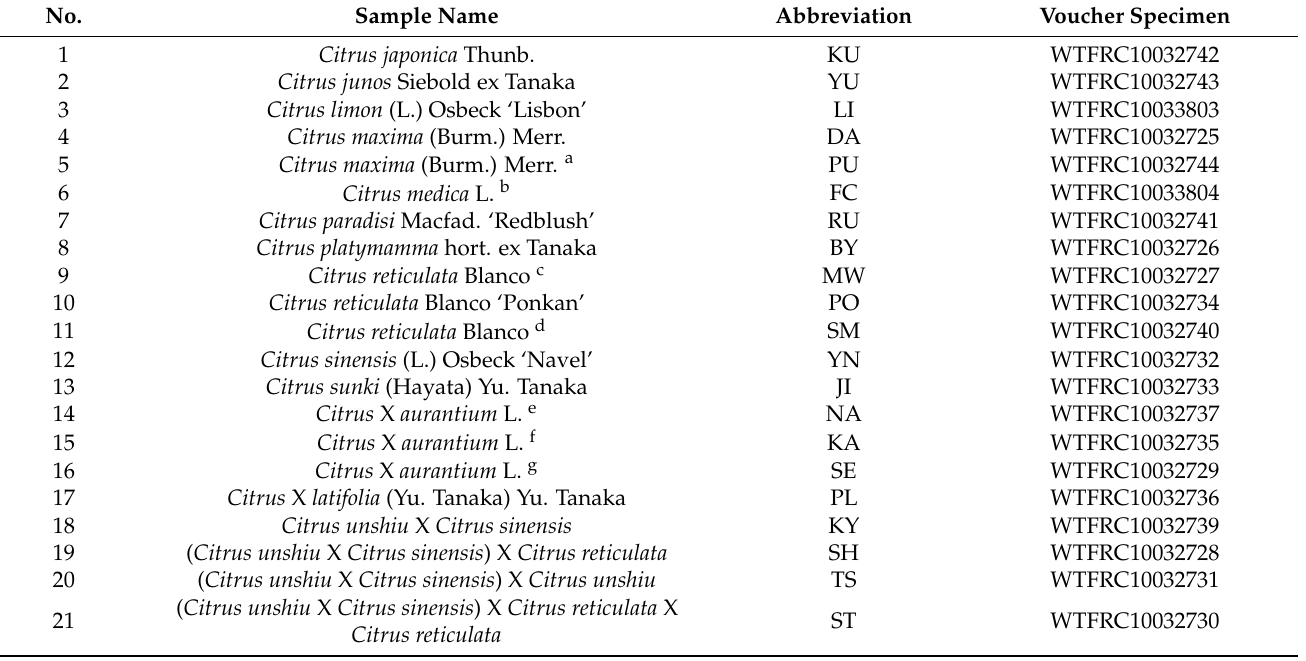
Table 2. Summary of cultivar information for citrus